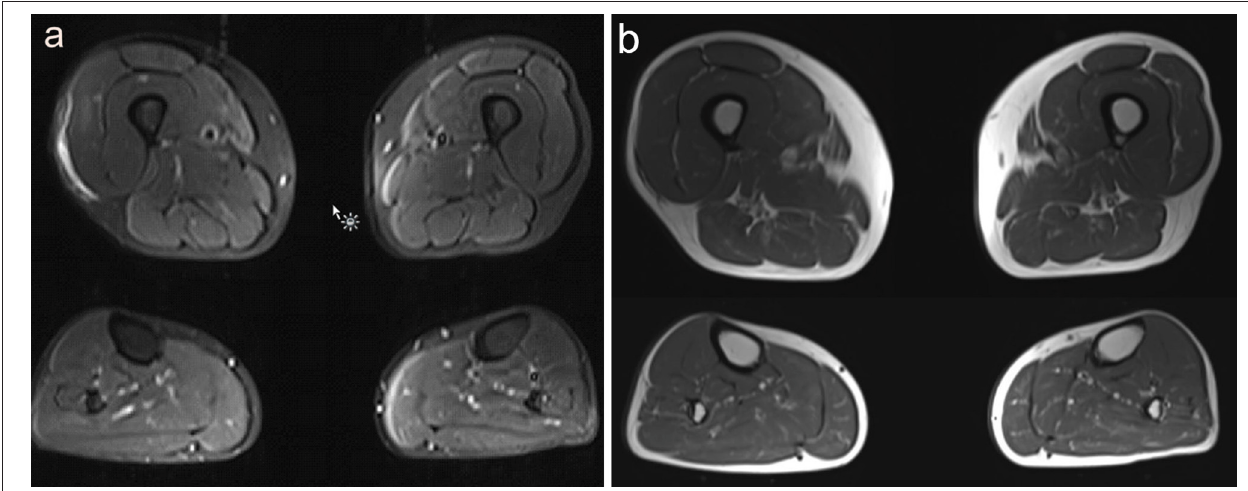
FIGURE 1 | Muscle MRI findings in Case 1. (a) Axial images of STIR MRI sequences through the upper and lower legs show subtle signal change in the right medial thigh, which had been attributed to the patient’s muscle biopsy a few days prior. Otherwise, no abnormality was identified on this study. (b) Axial images of T1 MRI sequences through the upper and lower legs show no abnormality.